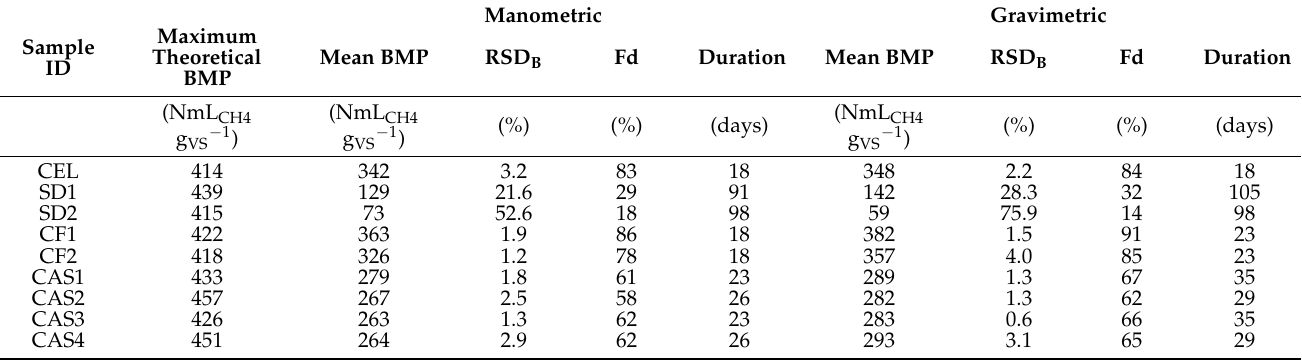
Table 2. Summary of the biochemical methane potential (BMP)